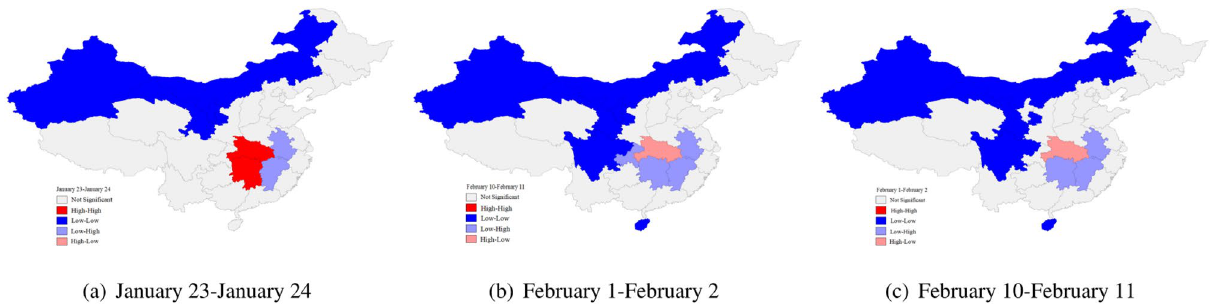
Figure 3. The spatio-temporal aggregation of the new diagnosed cases of COVID-19. Maps constructed using GeoDa 1.12.1 (https:// s2. loli. net/ 2022/ 01/ 11/ 5CZKu TaztY eD8wN.